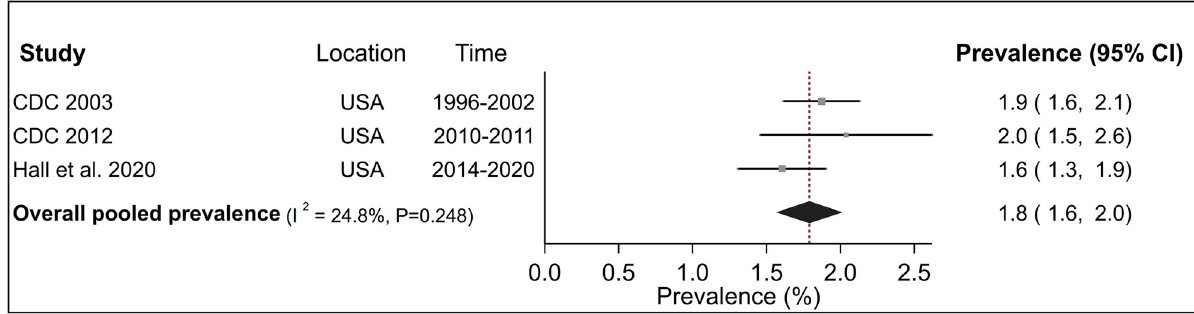
Fig 6. Forest plot from meta-analysis for overall prevalence of coal worker’s pneumoconiosis (CWP) among surface coal miners in the United States (USA). The red dashed line corresponds to the overall effect size to guide the eye.